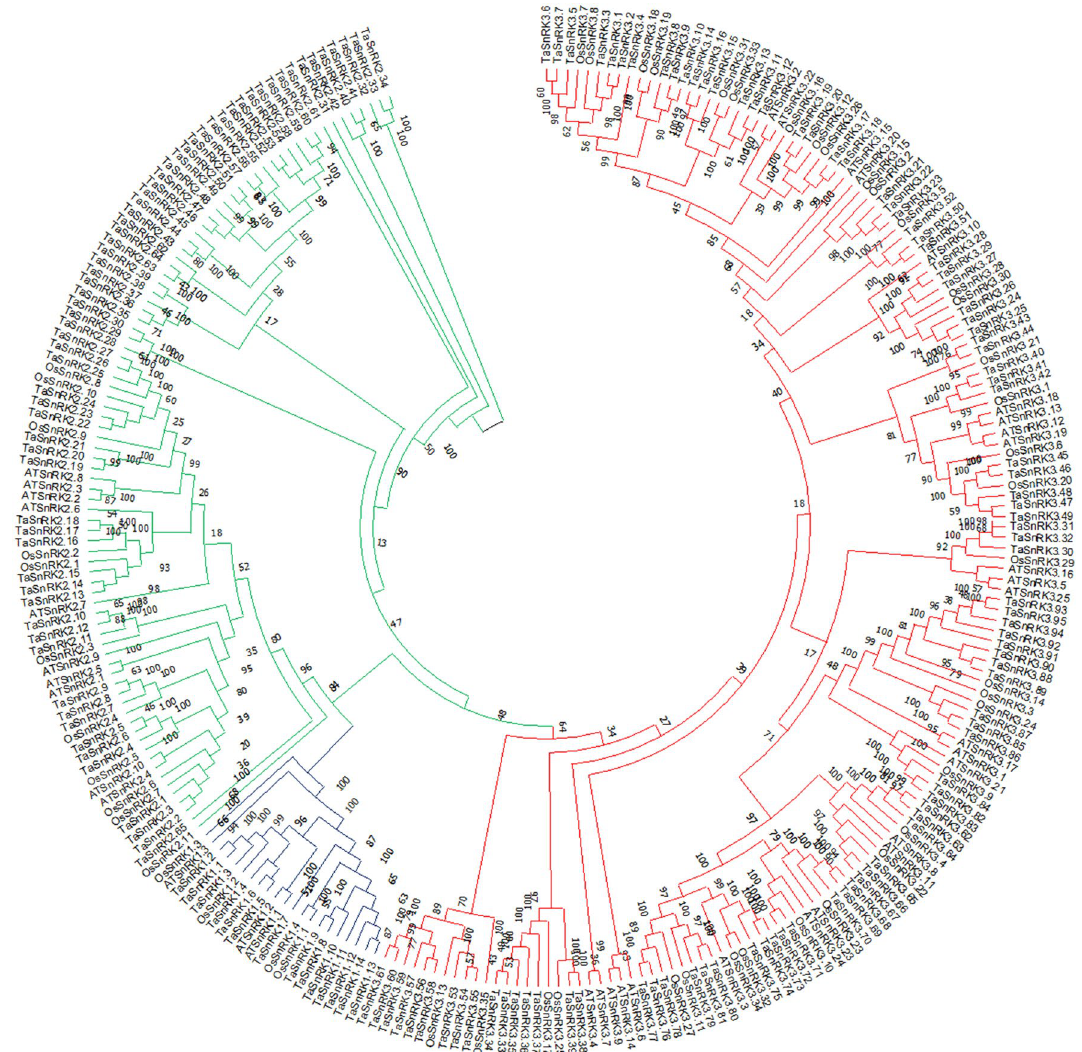
Figure 1. Phylogenetic tree of SnRK genes from T. aestivum, A. thaliana, and O. sativa . 174 SnRK genes from wheat, 38 from Arabidopsis and 50 from rice were clustered into three subgroups (SnRK1, SnRK2 and SnRK3). Wheat SnRK1, 2 and 3 subgroups are denoted as blue, green and red, respectively. The tree was generated using MEGA X software using the neighbor-joining